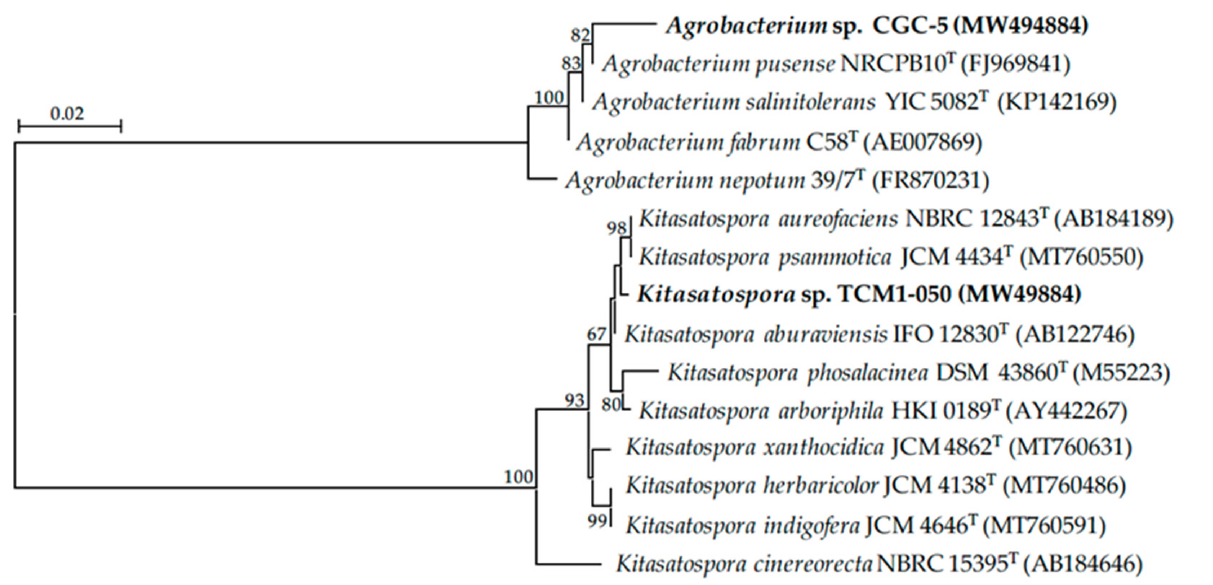
Figure 2. Unrooted neighbor-joining phylogenetic tree of teak rhizobacteria in this study. The tree was constructed using 16S rRNA gene sequence data derived from isolates CGC-5 and TCM1-050 (in bold) and their closely related phylogenetic species. The GenBank accession number of the gene sequence is presented in the parenthesis. Bootstrap values (based on 1000 replications) of >60% are at the tree’s nodes, and the scale bar represents 2% dissimilarity.